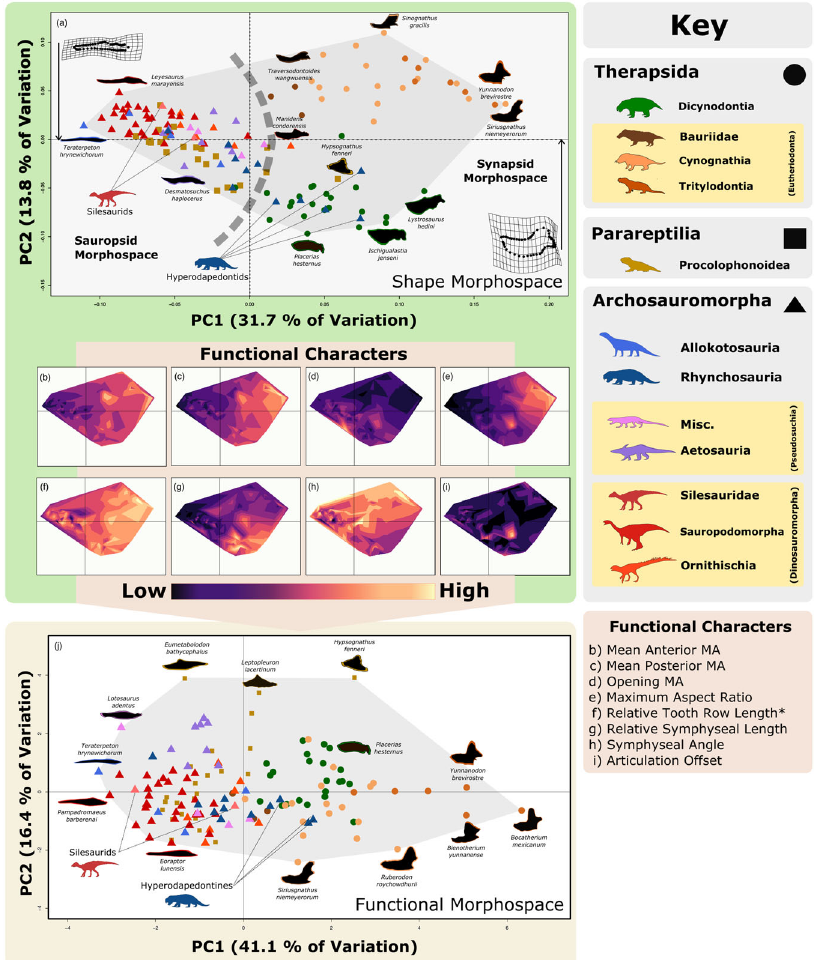
Fig. 1 Shape and functional morphospace occupation of early Mesozoic herbivores. a Shape morphospace based on geometric morphometric data. b – i Contour plot of (interpolated) functional character data mapped onto shape morphospace. Increasing magnitude of functional character values indicated by colour gradient from dark to light (scale varies across characters). j Functional morphospace based on the above functional characters. Misc., Miscellaneous pseudosuchians. MA, Mechanical advantage. Asterisk indicates tooth row length or length of the mandibular functional surface. N = 136 taxa. All silhouettes created by S.S., but some are vectorised from artwork by Felipe Alves Elias (https://www.paleozoobr.com/) and Jeff Martz (United States National Park Service), available for academic use with